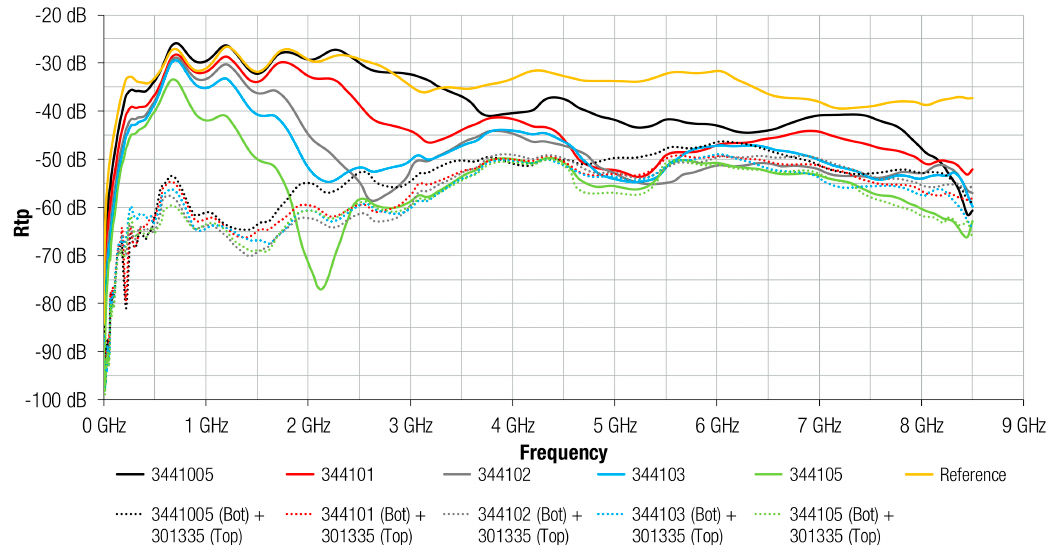
Figure 10. Re-radiation parameter of 3441 absorber material with different thicknesses and Al layer integrated.